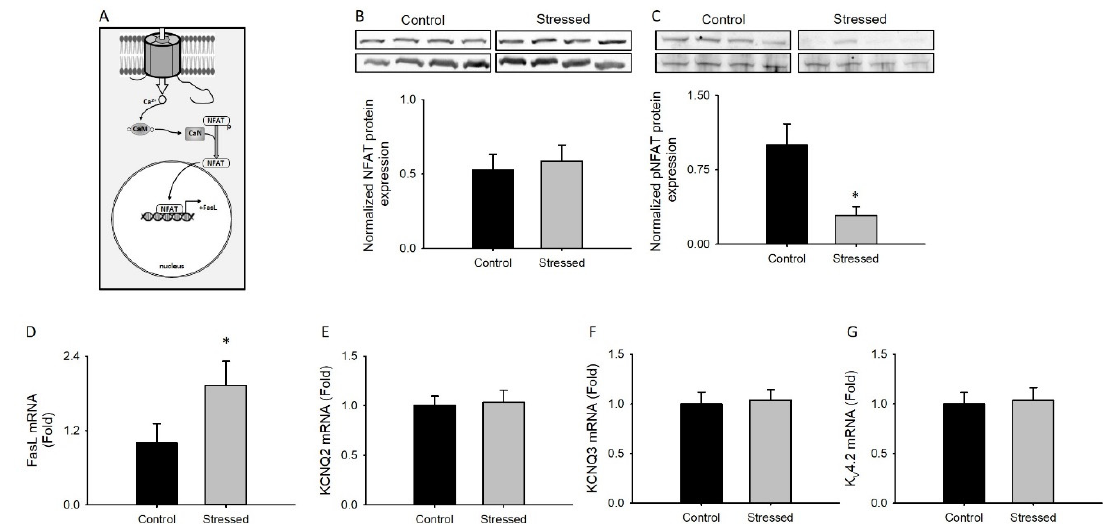
Figure 7. NFAT-dependent signaling in CRS-subjected animals: ( A ) Schematic diagram depicting the signaling pathway studied in this figure. Bar graph of NFAT protein expression normalized to α -tubulin ( B , n = 8) or pNFAT normalized to the total NFAT protein ( C , n = 8) from whole hippocampus lysates; in the upper part of each graph, a representative immunoblot is shown. Bar graph of semi-quantitative PCR expression of genes known to be controlled by NFAT such as FasL mRNA ( D ), KCNQ2 mRNA ( E ), KCNQ3 mRNA (F), or Kv4.2 mRNA ( G ) isolated from whole hippocampus of juvenile rat controls ( n = 8) or subjected to CRS for 3 weeks ( n = 8). Bar graphs are mean ± SEM; black bars are control animals, and gray bars correspond to CRS-subjected animals * p value < 0.05.